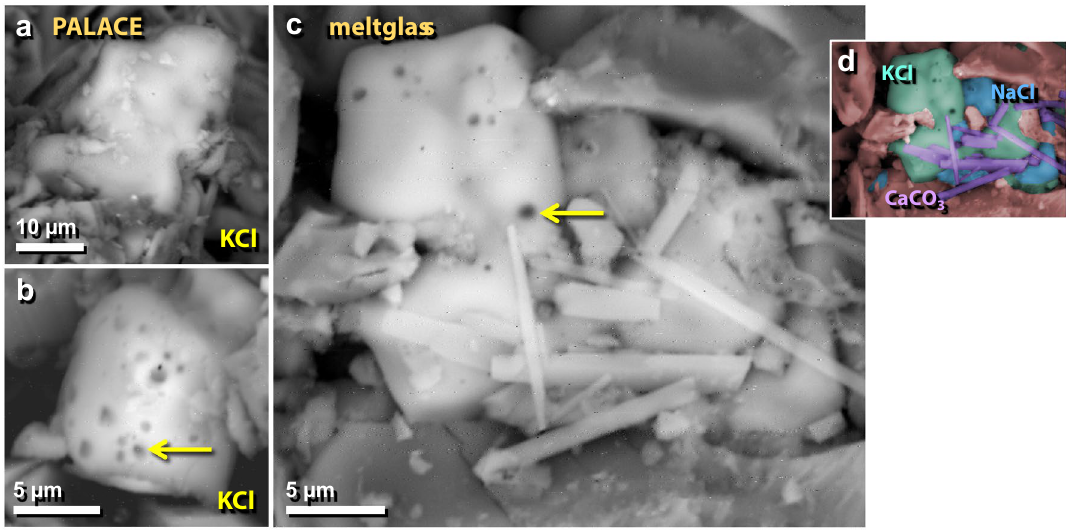
Figure 47. SEM images of melted potassium and sodium salt grains. ( a) , ( b ) Potassium chloride (KCl) grains melted into the surface of the palace mudbrick meltglass. ( c ) Melted NaCl and KCl grains. Bubbles at arrows suggest the salt grains exceeded their melting points. ( d ) Manually constructed EDS-based phase map of panel ‘ c ’, showing potassium chloride (KCl; green), sodium chloride (NaCl; blue), and spindle-like calcium carbonate crystals (CaCO 3 ; purple).